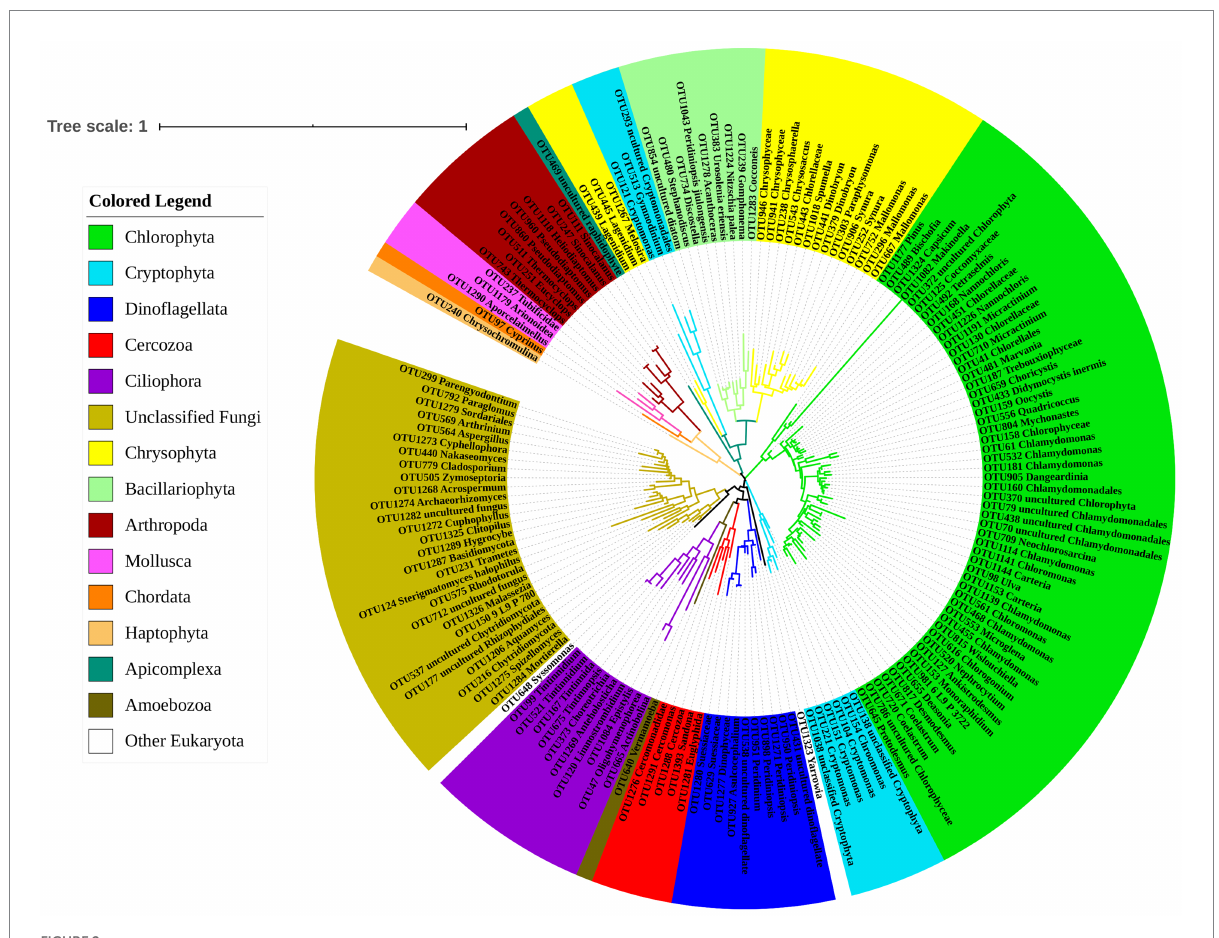
FIGURE 2 Phylogenetic tree of OTUs from the samples of Polyarthra gut contents based on Maximum Likelihood. The color coding of OTUs represents different